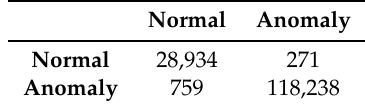
Table 11. Confusion matrix for the Adaboost random forest.